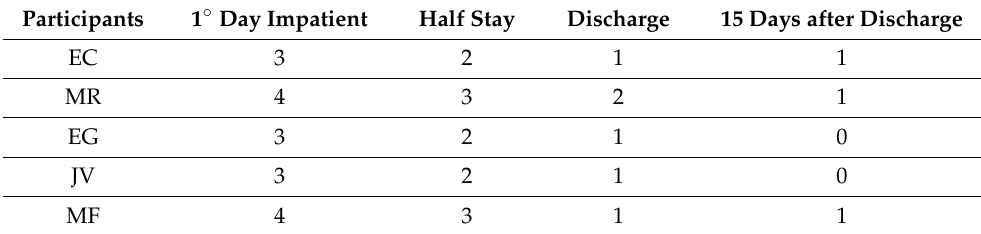
Table 3. Degree of dyspnea, during hospitalization and 15 days after discharge.